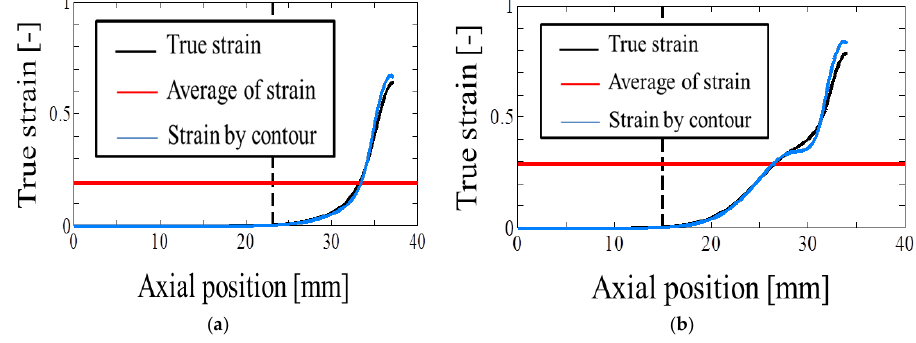
Figure 11. Distribution of the true strain obtained by Equation (4), a contour as a result of FEA and average of strain at each elapsed time. ( a ) 20 µ s; ( b ) 50 µ